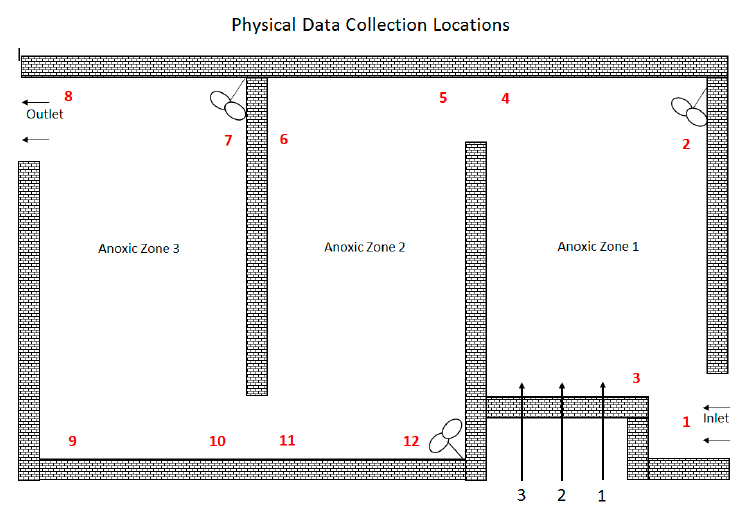
Figure 11. Sample locations in Anoxic Zone 1, 2 & 3. Table 2. Velocity results and comparison between CFD model and physical samples.